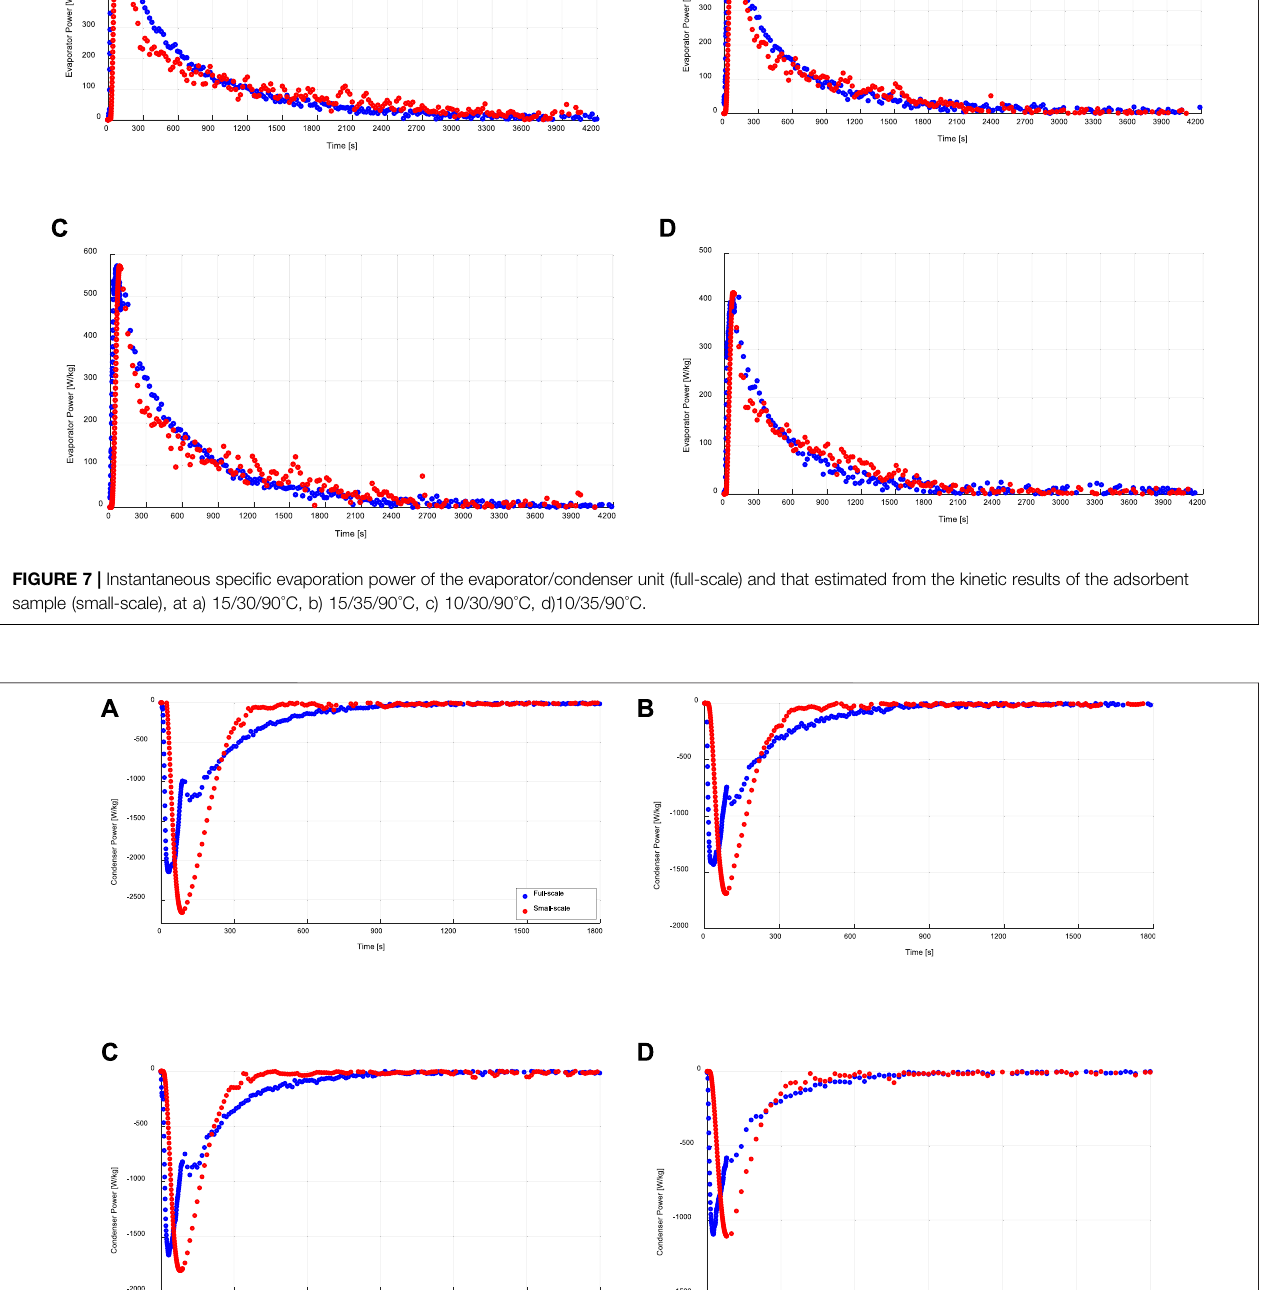
Frontiers in Energy Research |